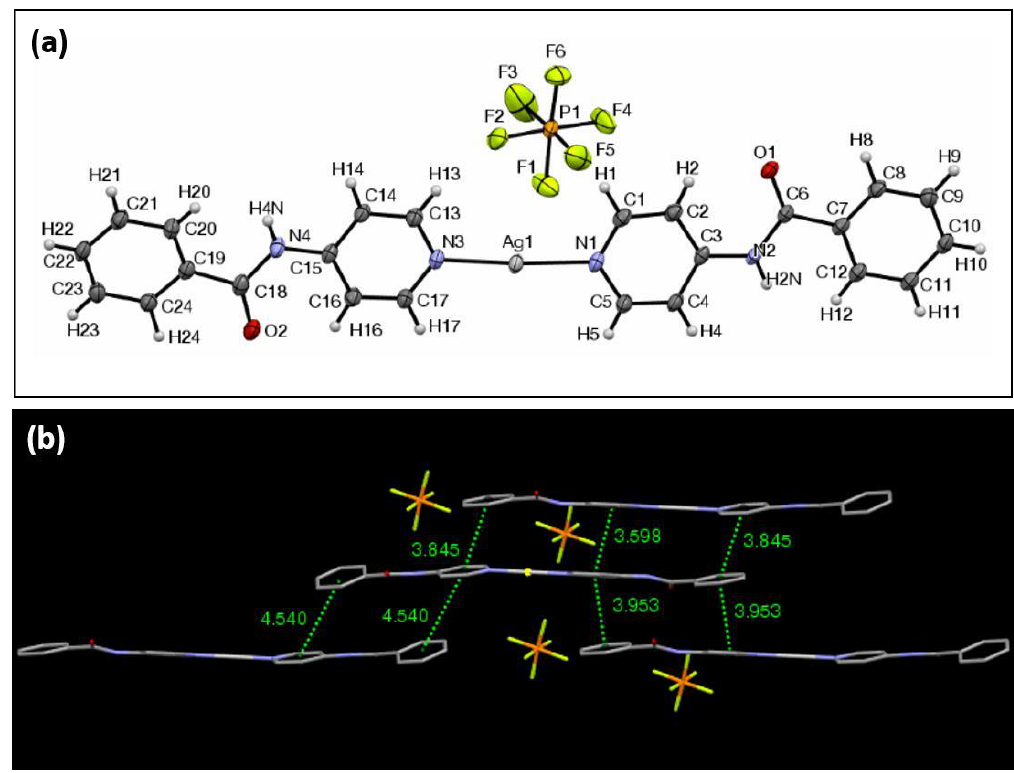
Figure 5. ( a ) The ORTEP view of complex 4 with ellipsoids drawn at 30% probability. ( b ) The view of the π–π interaction network of complex 4 , highlighting centroid – centroid distances of less than 4.54 Å